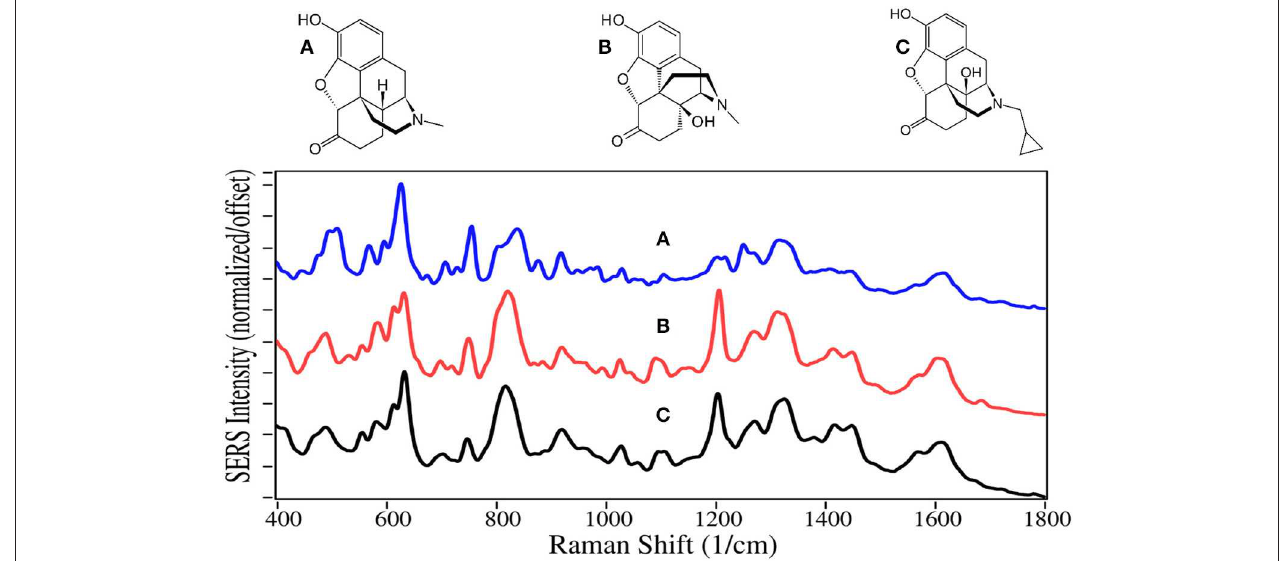
FIGURE 4 | Structures and 100 ppm SERS of (A) naloxone, (B) buprenorphine, and (C) norbuprenorphine.